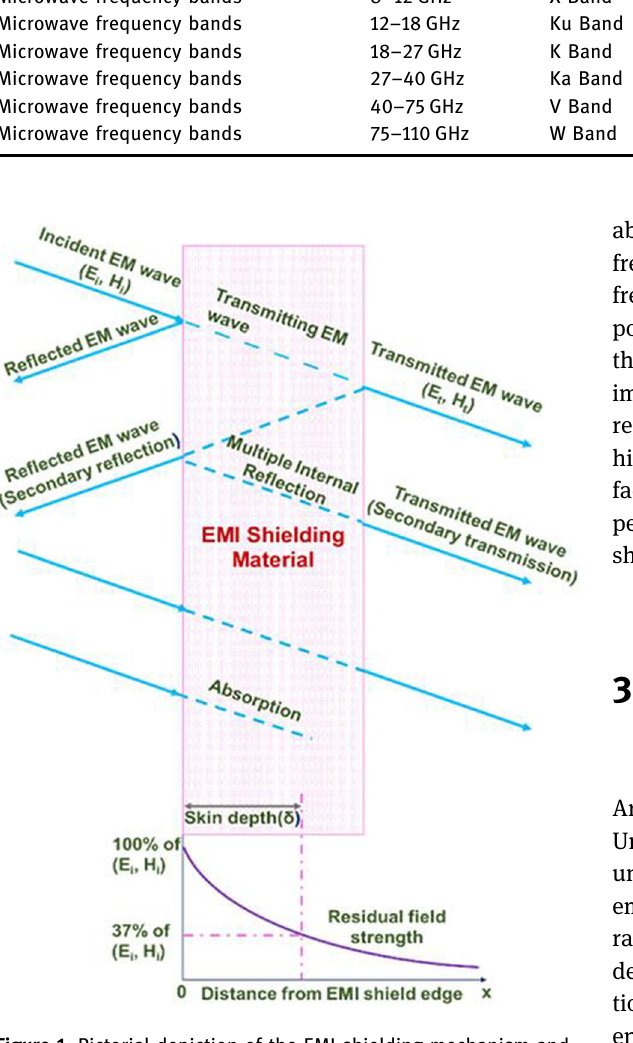
Figure 1: Pictorial depiction of the EMI shielding mechanism and skin depth of an EMI shielding material [ 60 ]